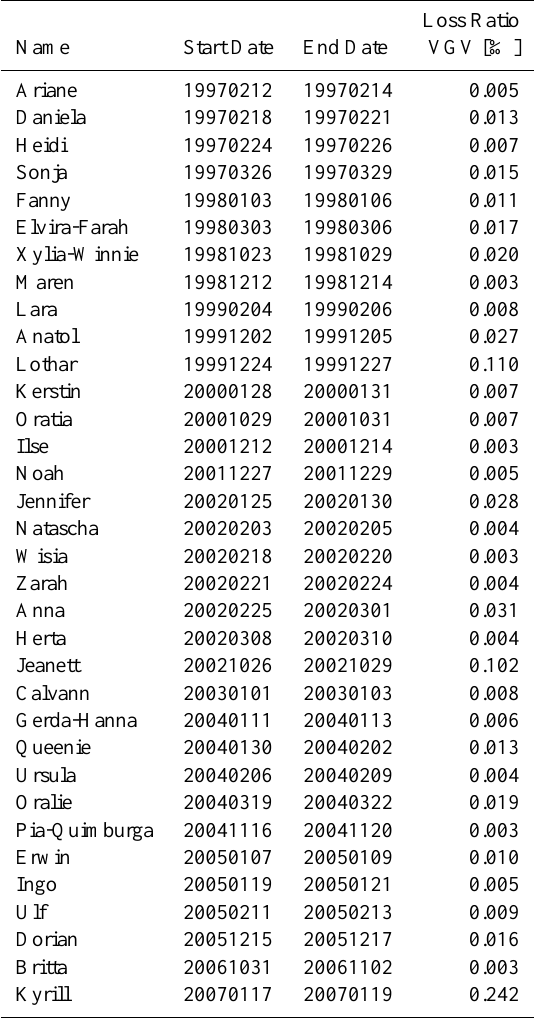
Major loss events in the period 1997–2007 identified from the VGV data are used for the calibration of the loss model. Events are identified on the basis of loss frequencies (i.e., number of claimed losses relative to the total number of insurance contracts) exceeding